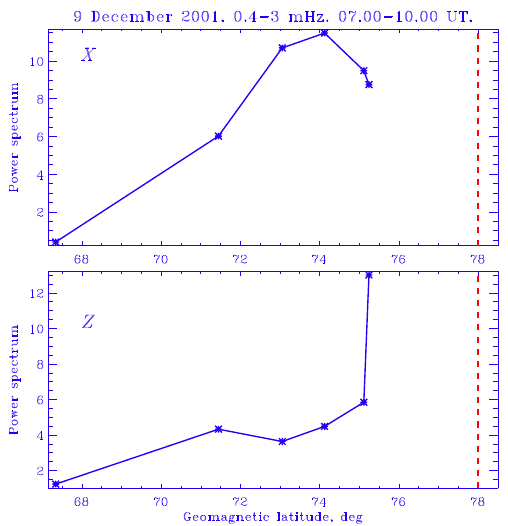
Figure 8. The CGM latitudinal distribution of band-integrated (0.7– 6.0mHz) hourly spectral power for the time interval 05:00 to 10:00UT 9 December 2001. The vertical dotted line (red) indi- cates the equatorward cusp boundary location, identified from Su- perDARN